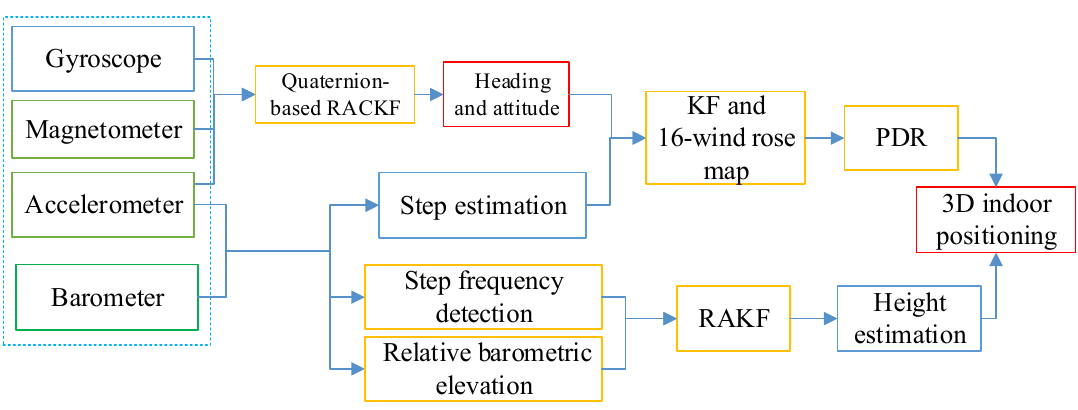
Figure 1. The frame of the proposed 3D indoor positioning method.